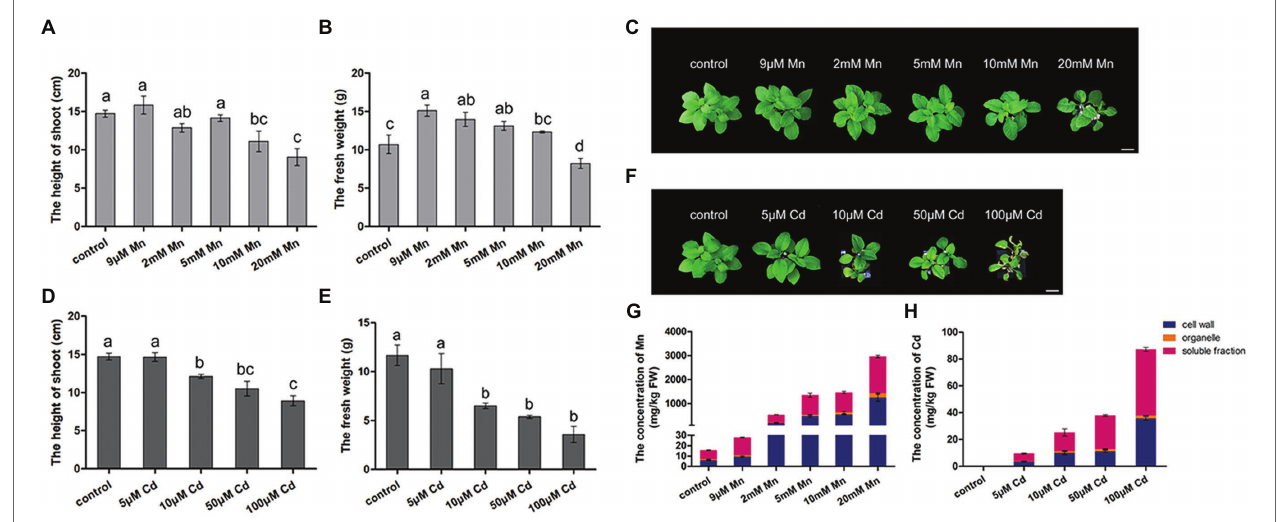
FIGURE 1 | Differential responses to Mn and Cd by pokeweed at phenotypic level. (A – C) Growth of seedlings subject to Mn treatments: (A) shoot height; (B) fresh weight; (C) photos showing growth; bar = 5 cm. (D – F) Growth of seedlings subject to Cd treatments: (D) shoot height; (E) fresh weight; (F) photos showing growth; bar = 5 cm. (G) Mn concentrations in cell walls (F1), organelles (F2), and the soluble fraction (F3); and (H) Cd concentrations in the same three leaf components. Data represent mean ± SD of three biological replicates per treatment for ( A – E) and six biological replicates per treatment for (G , H) . Letter annotations indicate significant differences according to Duncan’s multiple range test ( p <